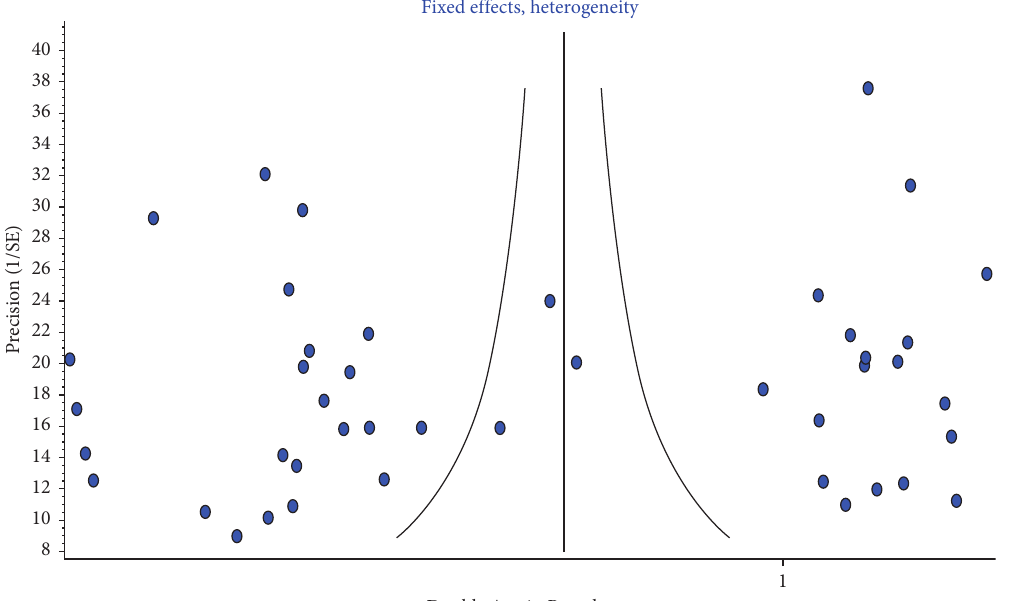
Figure 11: Funnel plot of global patient-level prevalence of three-rooted